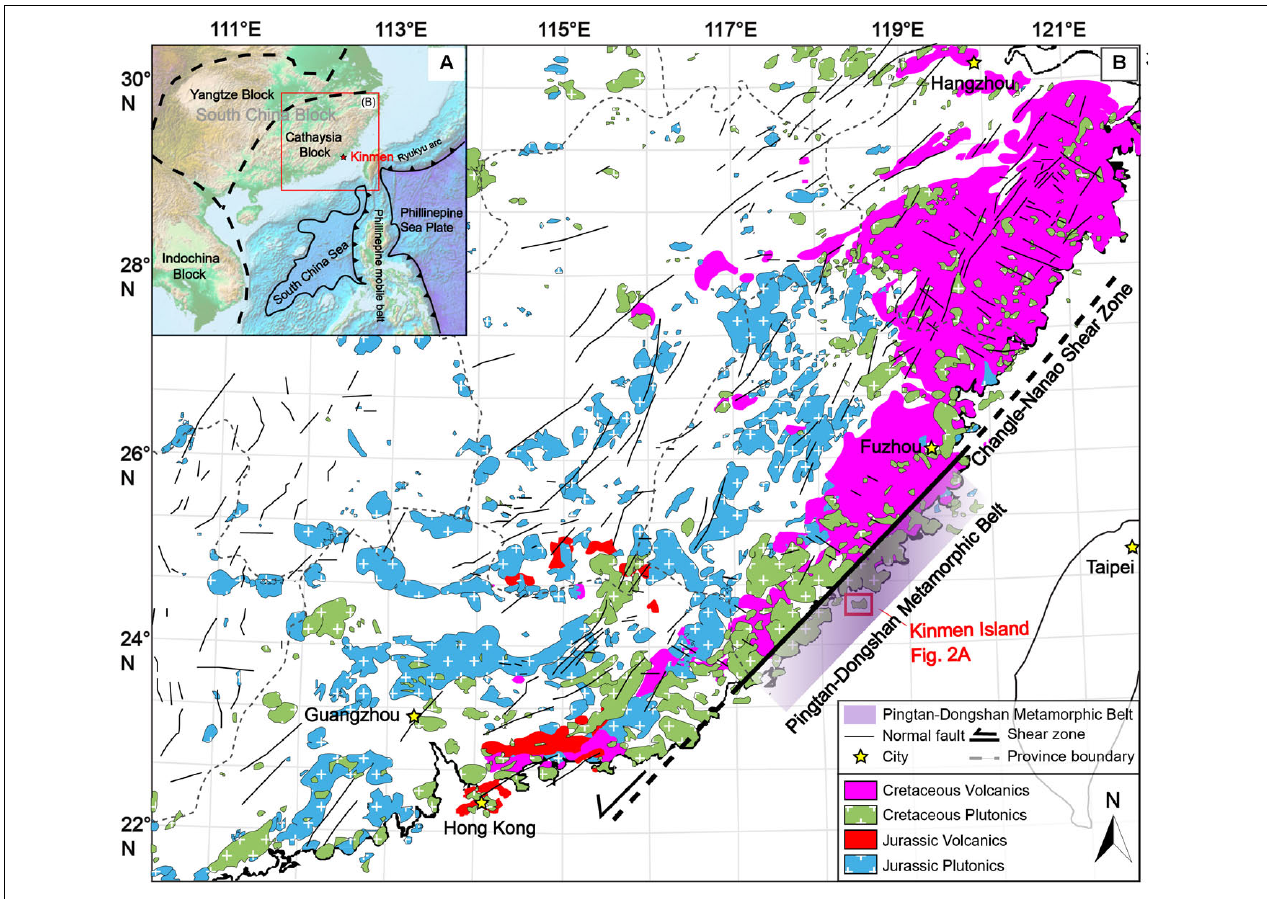
FIGURE 1 | Simplified tectonic and geological map of southeast Asia. (A) Topography map showing tectonic components of southeast Asia under present-day configuration. The black dashed lines mark the boundaries of the tectonic blocks while the black solid lines mark the boundaries between continental crust and oceanic crust. Solid black lines with triangles indicate the subduction zones. (B) Geological map modified and compiled from Li J. et al. (2014) and Zhou et al. (2006) illustrating the distribution of the Jurassic and Cretaceous plutonics and volcanics, Mesozoic normal faults, Changle-Nanao Shear Zone (CNSZ), and the Pingtan-Dongshan Metamorphic Belt (PDMB). The red rectangle indicates the study site in this